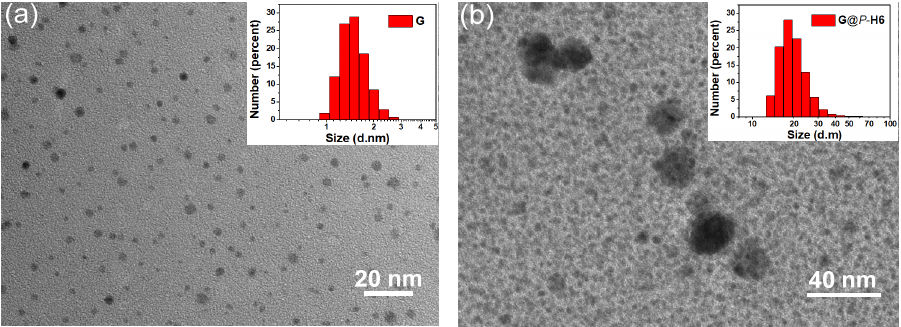
Figure 4. TEM images of ( a ) the silver cluster G (inset: DLS image of G ) and ( b ) the nanocluster complex G @ P - H6 (inset: DLS image of G @ P - H6